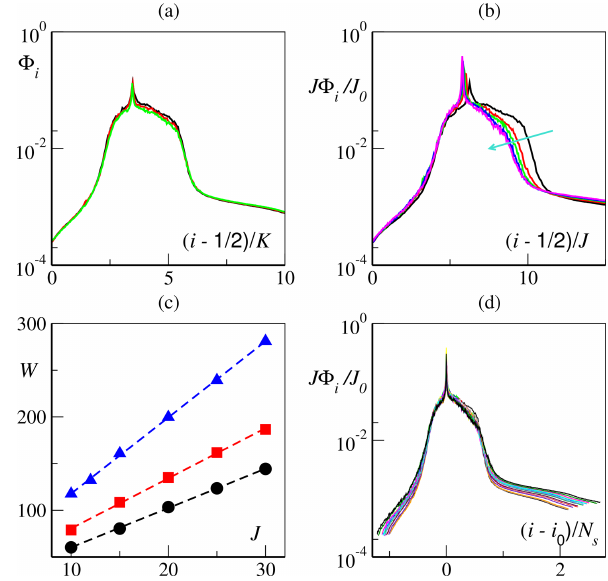
Figure 4. Slow-bundle scaling for h = 0 . 5 and f = 1. (a) CLV time-averaged X -projected norm (cid:56) i for K = 18, 24 and 36 and J = 10 vs. the rescaled index (i − 0 . 5 )/K . (b) Rescaled (see main text) CLV average projection norm (cid:56) i for K = 18 and J = 10, 15, 20, 25 and 30 (increasing along the cyan arrow) vs. the rescaled index (i − 0 . 5 )/J . A lack of precise collapse can be appreciated on the rightmost side of the central band. (c) Central band width W (see main text for details) as a function of J for K = 18 (black circles), K = 24 (red squares) and K = 36 (blue triangles). The best lin- ear fits, marked by the dashed lines, are W = 18 ( 1 ) + 4 . 20 ( 5 )J (for K = 18), W = 26 ( 2 ) + 5 . 4 ( 1 )J ( K = 24) and W = 36 ( 2 ) + 8 . 2 ( 2 )J ( K = 36). (d) Rescaled CLV average projection norm (cid:56) i for K = 18, 24 and 36 and J = 10, 15, 20, 25 and 30 (all combinations) vs. the rescaled index (i − i 0 )/N s . Here i 0 is the index of the 0-CLV and N s = K( 1 + αJ) , with α ≈ 0 . 22 (see text). We choose the vertical axis rescaling reference as J 0 =